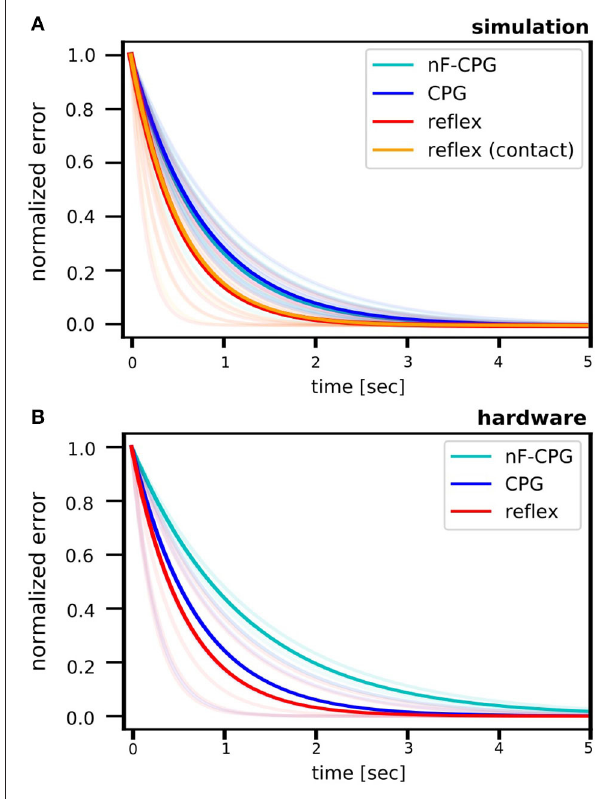
FIGURE 4 | Fitted curves for the cumulative errors determined per period in the fall scenario for the biomimetic leg. Results are shown for the simulation (A) and the hardware setup (B) . For better comparison, all error curves were scaled by the initial disturbance value at the fall ( t = 0), thus all starting at 1. The light-colored curves show the individual fits for each fall height. Overall, the reflex was fastest to recover a stable motion. In the simulation, the reflex was tested with two different methods, either triggered through (1) contact sensing (orange) or (2) a torque threshold (red). As expected by theory, no difference between the two trigger methods could be found, thus, validating functional equivalence. While triggering based on ground contact is the bioplausible strategy, we chose the latter to implement the reflex on the robotic leg in hardware without the need of additional